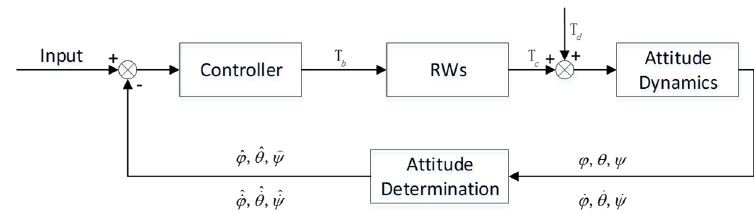
Figure 1. Block diagram of the satellite zero-momentum system.